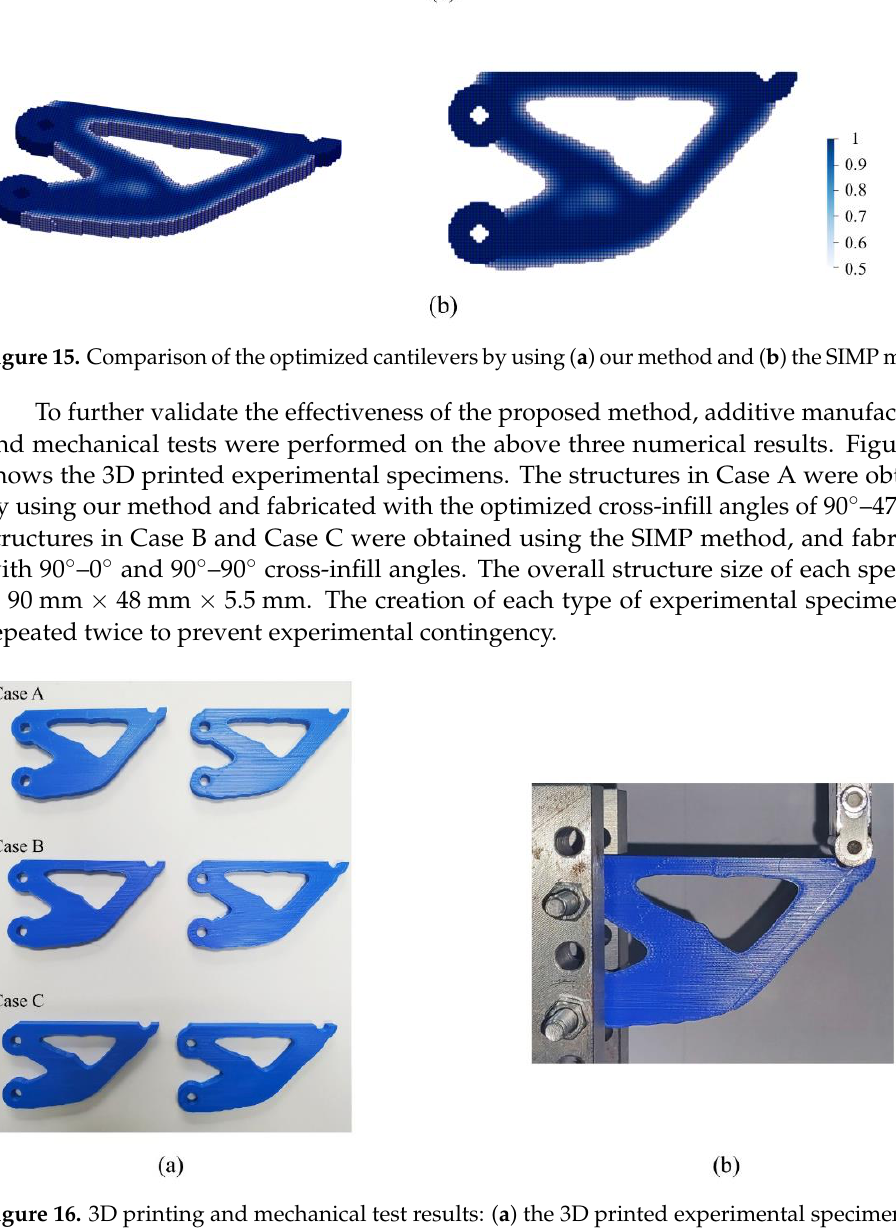
Figure 16. 3D printing and mechanical test results: ( a ) the 3D printed experimental specimens, and ( b ) the mechanical test setup.